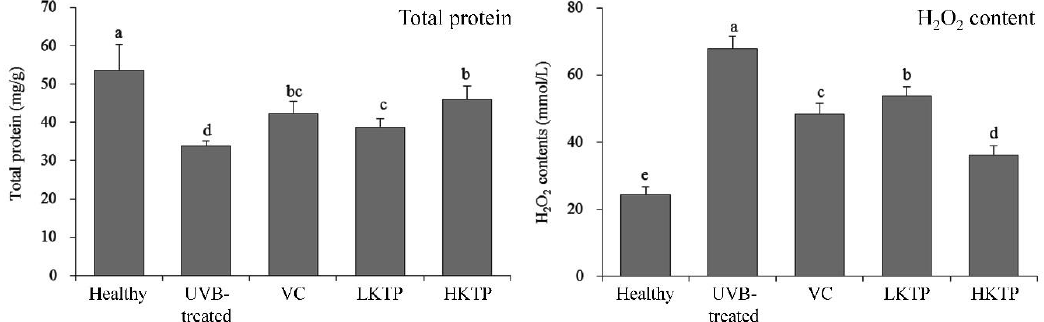
Figure 2. Total protein and H 2 O 2 contents of skin tissue in SKH1 hairless mice with UVB-induced skin aging. Values presented are the means ± standard deviation (N = 10/group). a–d Mean values with different letters in the same bars are significantly different ( p < 0.05) according to Duncan’s new MRT. VC: mice were smeared with 5.0% VC solution; LKTP: mice were smeared with 2.5% polyphenols of Kuding tea; and HKTP: mice were smeared with 5.0% polyphenols of Kuding tea.